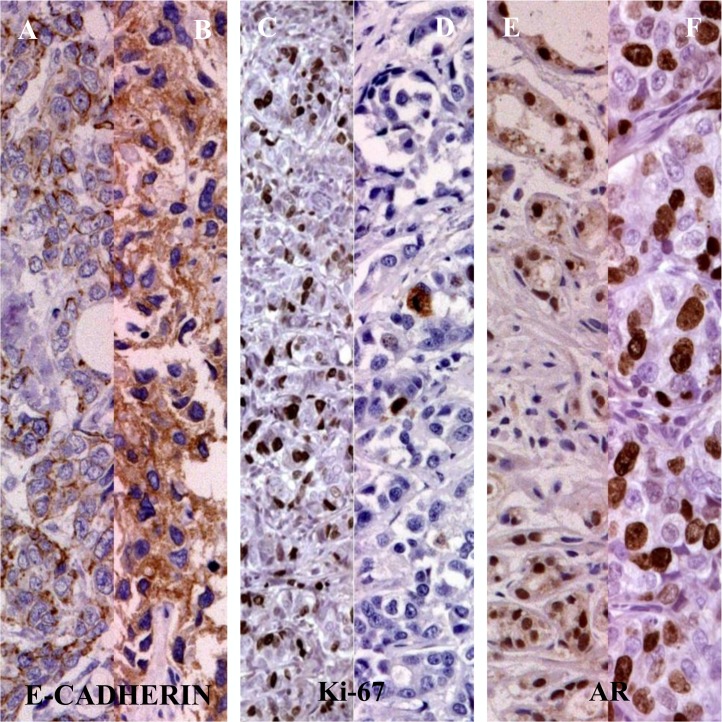
The AR, E-Cadherin and Ki 67 expression in 45 patients TNBC.Legend: [A, B] negative/positive AR staining; [C, D] E-cadherin negative/positive staining; [E, F] Ki-67 level < or ≥ 20%.